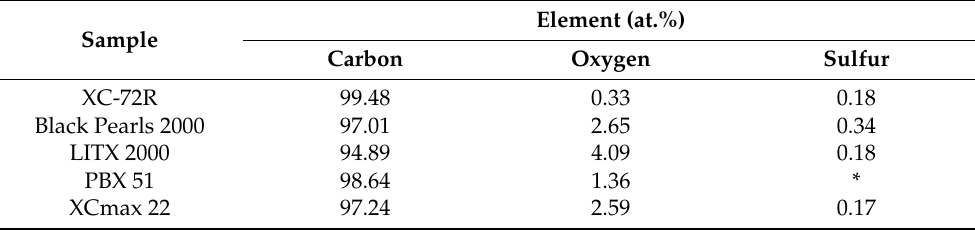
Table 3. Elemental composition of the pristine CBs, obtained through XPS quantitative